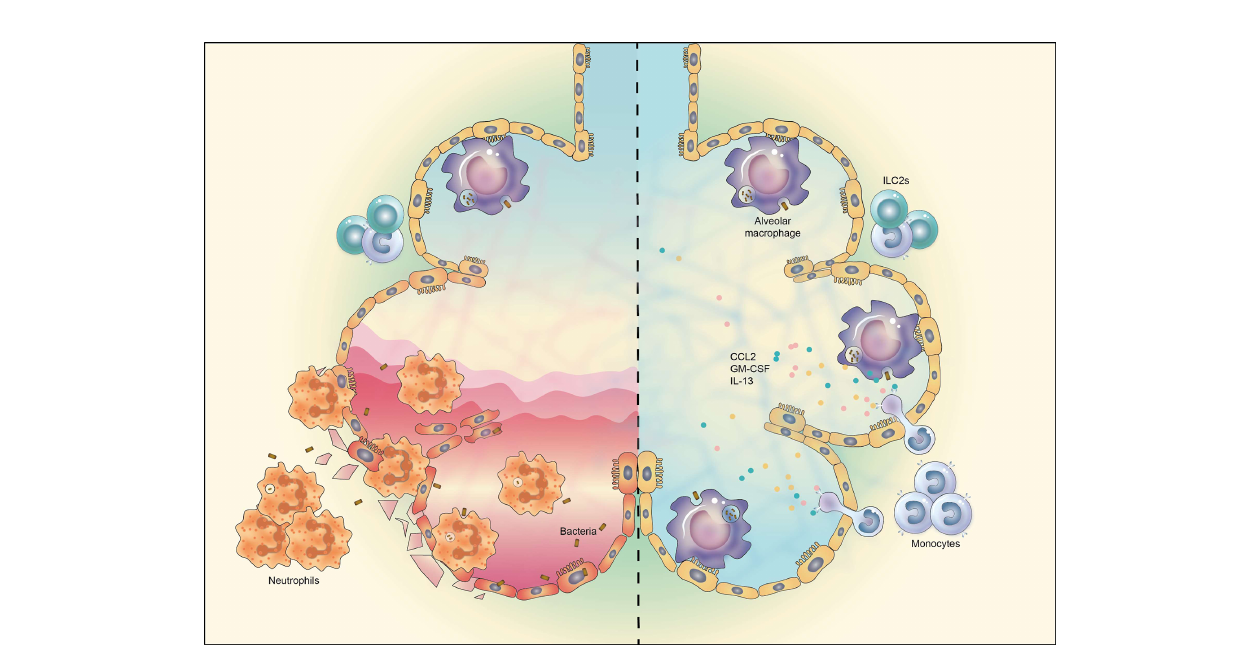
FIGURE 6 | Schematic representation of manipulation of AM reconstitution in vivo to enhance the resistance against respiratory bacterial infection after TCD-BMT. The reconstitution of donor monocyte-derived AMs after TCD-BMT is defective due to the insuf fi cient support of lung microenvironment, attributable mainly to reduced ILC2 cells and IL-13 production. TCD-BMT mice fail to eliminate inhaled pulmonary bacteria via AM-dependent immunity, which causes epithelia cell damage and severe lung in fl ammation dominated by neutrophil in fi ltration ( left ). Exogenous administration of a cytokine cocktail containing recombinant murine GM- CSF, IL-13, and CCL2 could promote donor monocyte-derived AM reconstitution and thus enhance the resistance of TCD-BMT mice against pulmonary bacterial infection ( right ). AM, alveolar macrophage; TCD, T cell-depleted; BMT, bone marrow transplantation; GM-CSF, granulocyte-macrophage colony-stimulating